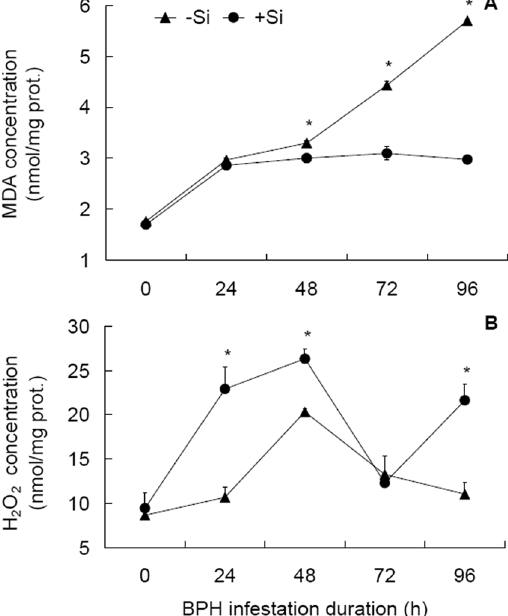
Figure 1. Concentrations of malondialdehyde and H 2 O 2 in rice leaf sheaths in response to Si amendment and BPH infestation. ( A ) Malondialdehyde, MDA. ( B ) H 2 O 2 + Si = silicon amendment to rice plants at 112 mg Si/ kg nutrient solution, − Si = no silicon amendment. Error bars represent 1 × SE. n = 3 (biological replicates). * Significant difference between + Si and − Si plants at a certain time post BPH infestation at P < 0.05 via independent samples T